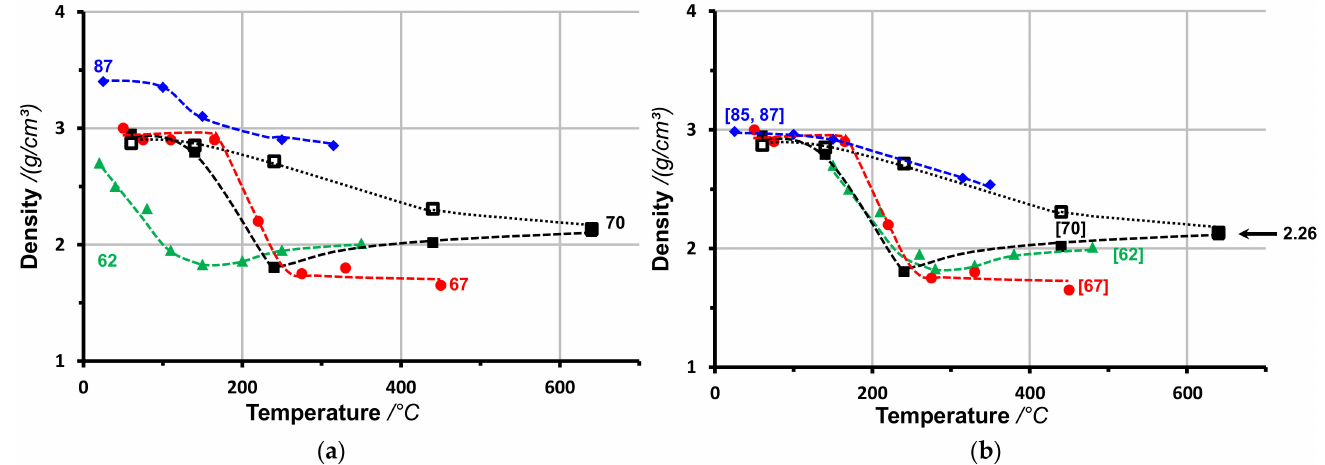
Figure 20. Dependence of the density on the substrate temperature for carbon films prepared by vacuum arc deposition. Filtered dc arc deposition with ion energies of 50 eV (empty black squares [70]), 60 eV (blue diamonds [87]), 90 eV (red circles [67]) and 100 eV (solid black squares [70] and pulsed cathodic Laser-Arc (80–90 eV, green triangles [62]). ( a ) Original values. ( b ) Corrected values: 1) ρ ([87]) from s ([85]) in Figure 18 according to Equation (1) (instead from XRR), ρ ([62]) shifted upwards by 130 K due to assumed ion induced surface